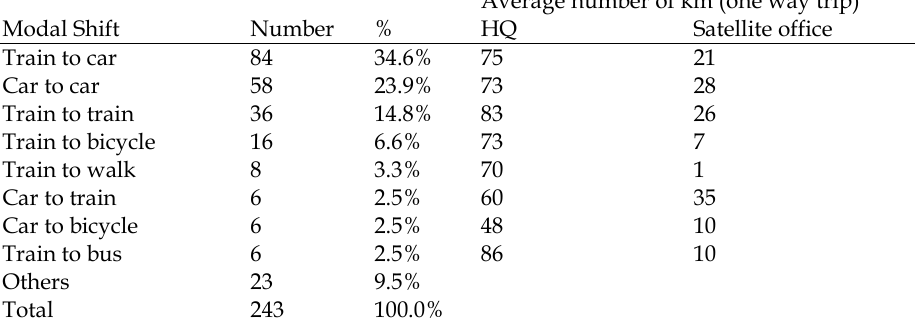
Table 3. Modal shift, number of respondents (total and percentage) and average number of vehicle kilometres for commuting to HQ and to satellite office by satellite office